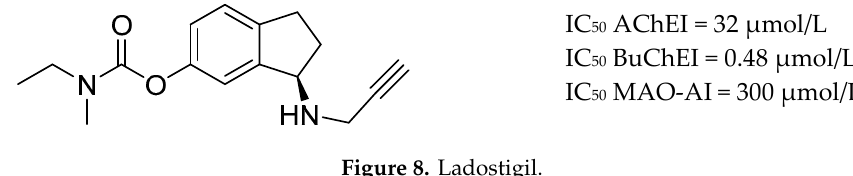
Figure 8. Figure 8. Ladostigil.